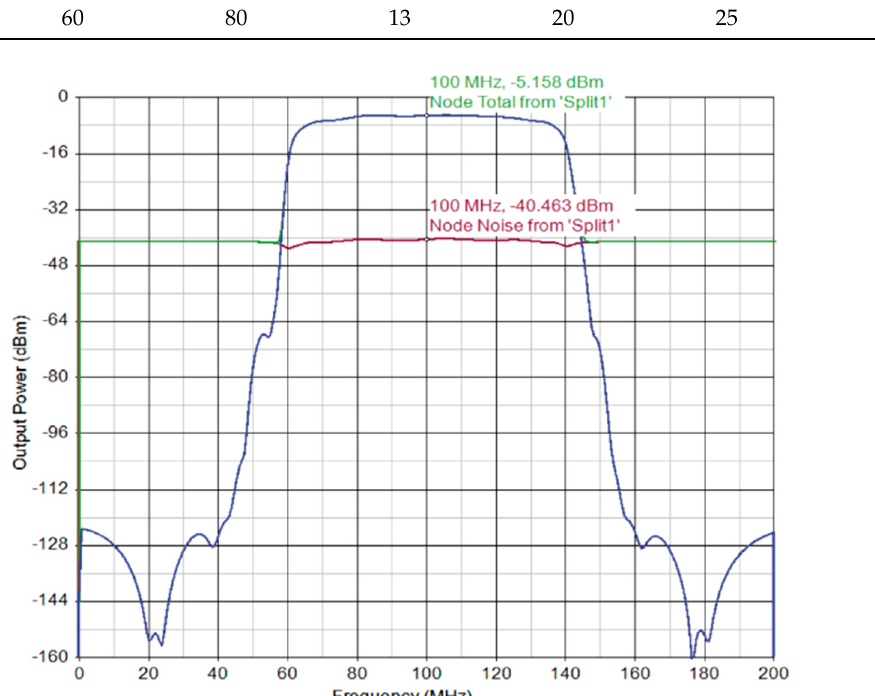
Figure A6. ( a ) The RF down-converter cascaded gain, ( b ) cascaded noise figure, ( c ) compression curve, from RF frequency 3580 MHz to 100 MHz IF frequency.